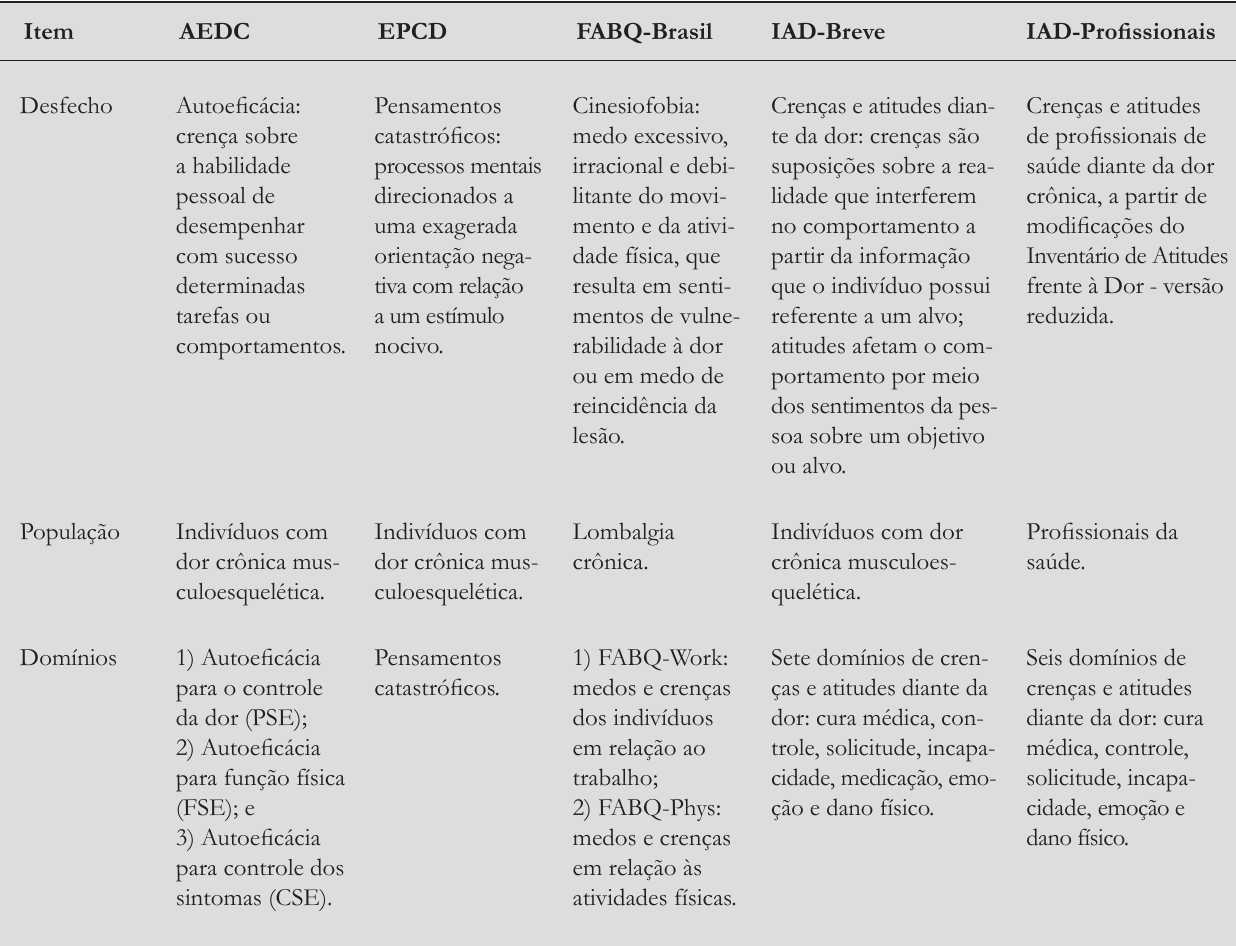
Tabela 1 - Resumo da estrutura, con fi abilidade e validade da Escala de Autoe fi cácia para Dor Crônica (AEDC), Escala de Pensamentos Catastró fi cos sobre Dor (EPCD), Fear Avoidance Beliefs Questionnaire – Brasil (FABQ-Brasil), Inventário de Atitudes frente à Dor – versão reduzida (IAD-Breve), e Inventário